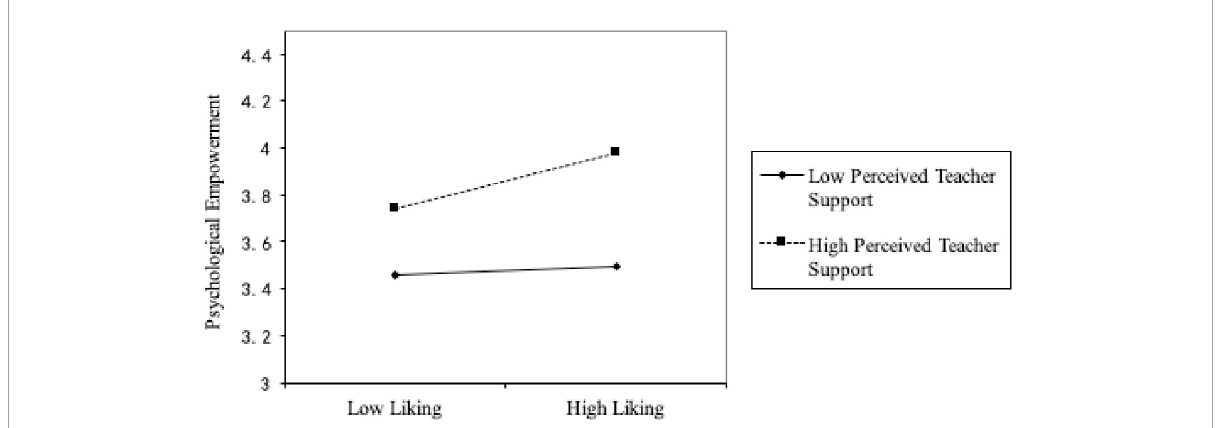
FIGURE2 The effect of interaction between liking and perceived teacher support on psychological empowerment.